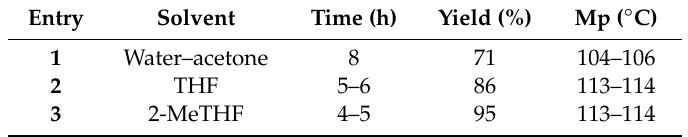
Table 1. Reaction of isatoic anhydride using di ff erent solvents to a ff ord the product 3a . Entry Solvent Time (h) Yield